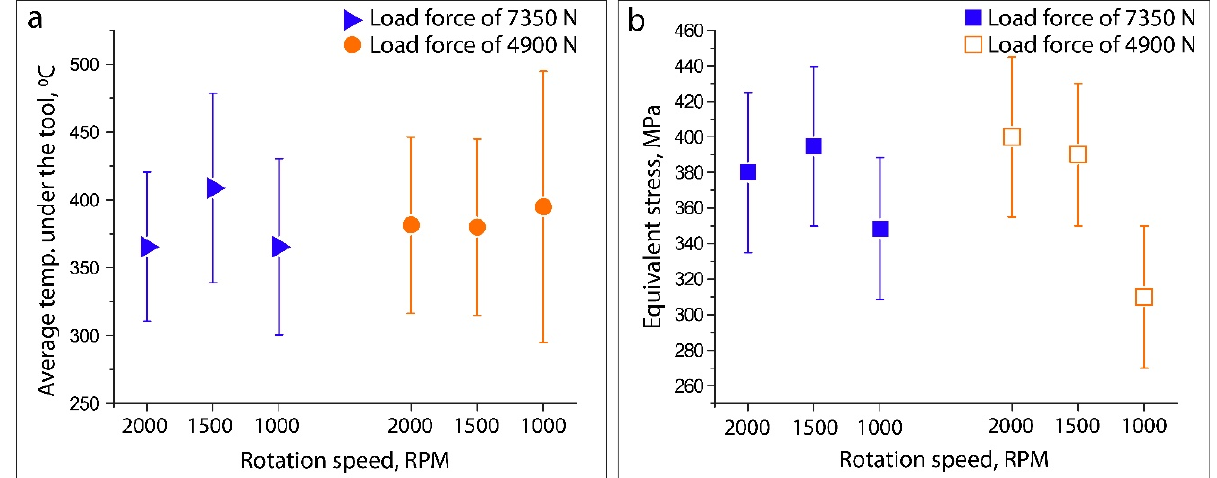
Figure 8. Numerical results of average temperature ( a ) and equivalent stress ( b ) along the tool shoulder–workpiece interface as a function of load force and rotation speed combination.